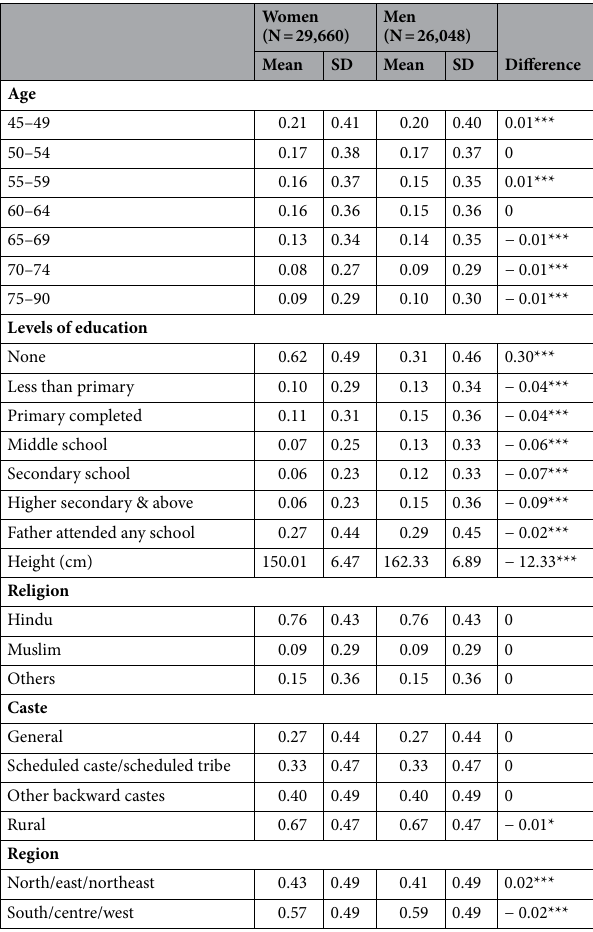
Table 1. Summary statistics. Data source Longitudinal Ageing Study in India (LASI), 2017–2019. All statistics are weighted. ***p < 0.01, **p < 0.05, *p <